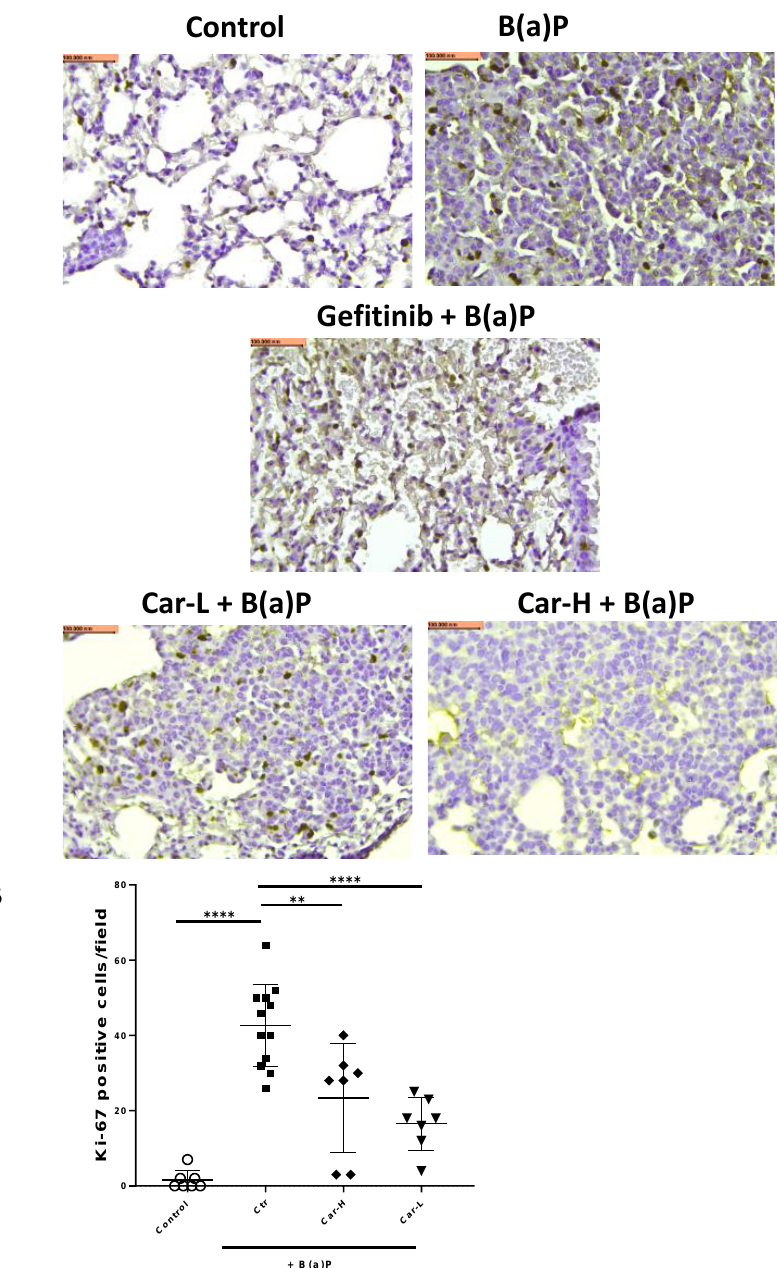
Figure 6. Effects of carvedilol on B(a)P-induced Ki-67 expression in lung tumors. ( A ) Representative cross-section images of lung after immunohistochemical staining with Ki-67 antibody ( × 20). Scale bars: 100 µ m. ( B ) Number of Ki-67 positive cells in lung tumors per microscopic field. Data are expressed as mean ± SD. An ordinary one-way ANOVA followed by Dunnett’s multiple comparison test was used to assess statistical differences. **: p < 0.01, ****: p < 0.0001.